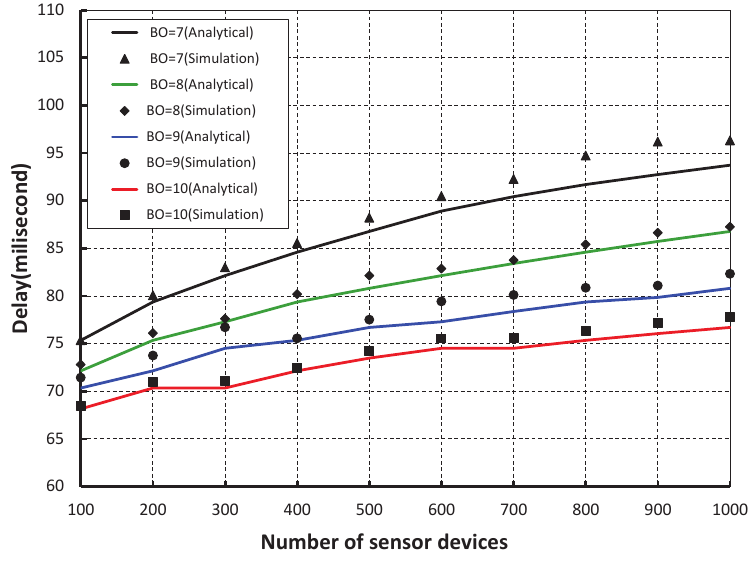
Figure 12. Validation of packet delay for different beacon